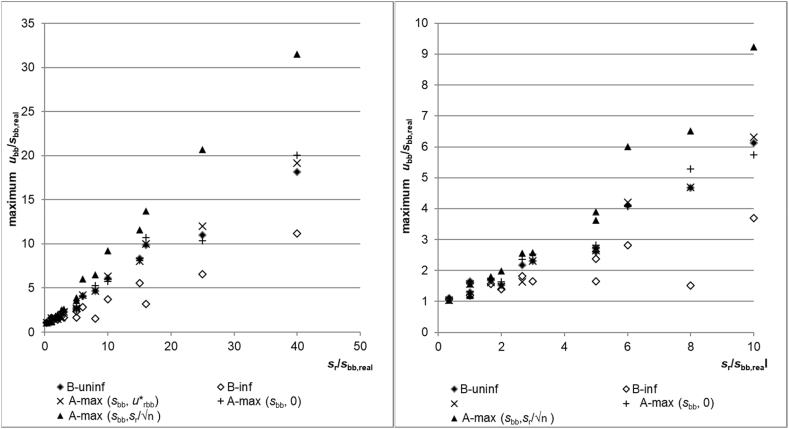
Maximum overestimation of sbb,real. Left all sr/sbb,real ratios. Right: only area for sr/sbb,real up to 10.